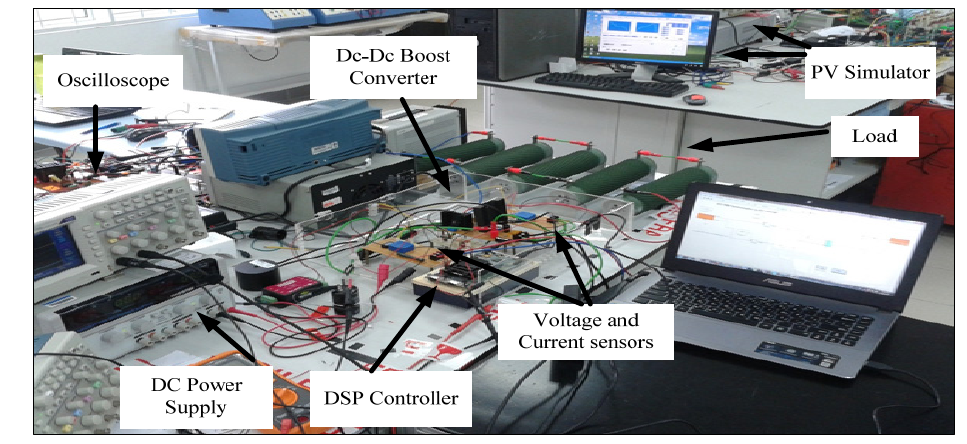
Figure 17. The hardware setup.